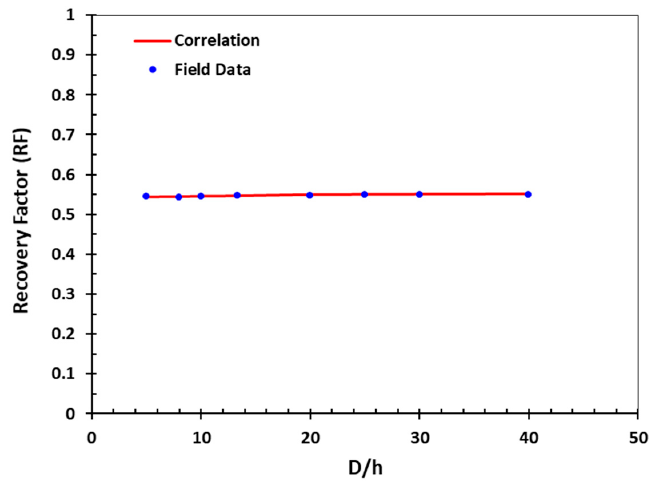
Figure 13. RF vs. fracture permeability to matrix permeability ratio for the database analyzed.